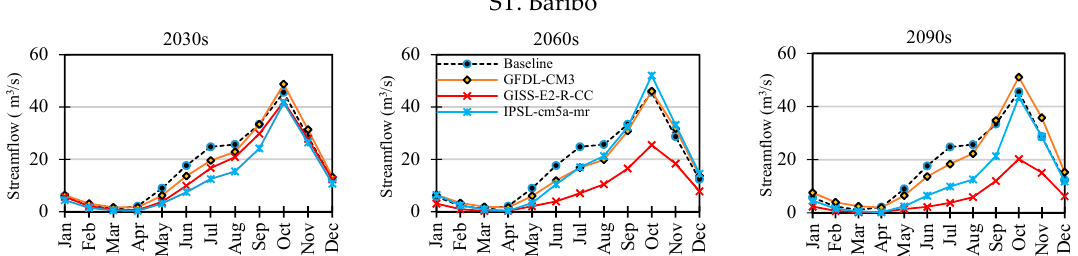
Figure A2. Mean monthly baseline river flows and 2030s, 2060s, and 2090s climate change scenario flows.